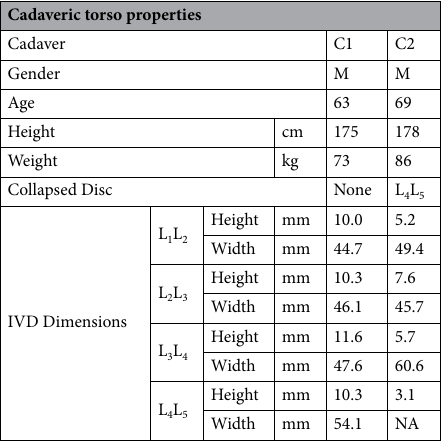
Table 1. Cadaveric torso properties. The cadaver measurements are from a previous work 45 . IVD width is the lateral width.